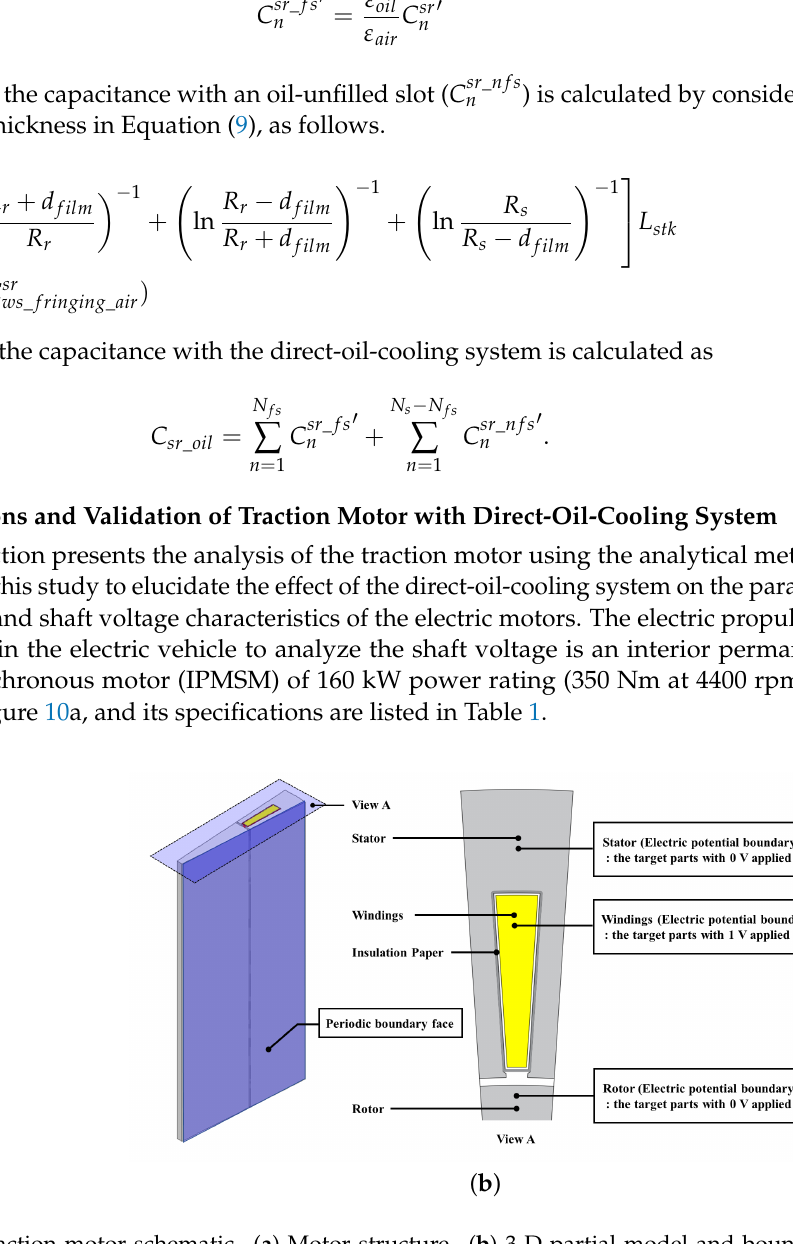
Figure 10. Traction motor schematic. ( a ) Motor structure. ( b ) 3-D partial model and boundary conditions for the FEM